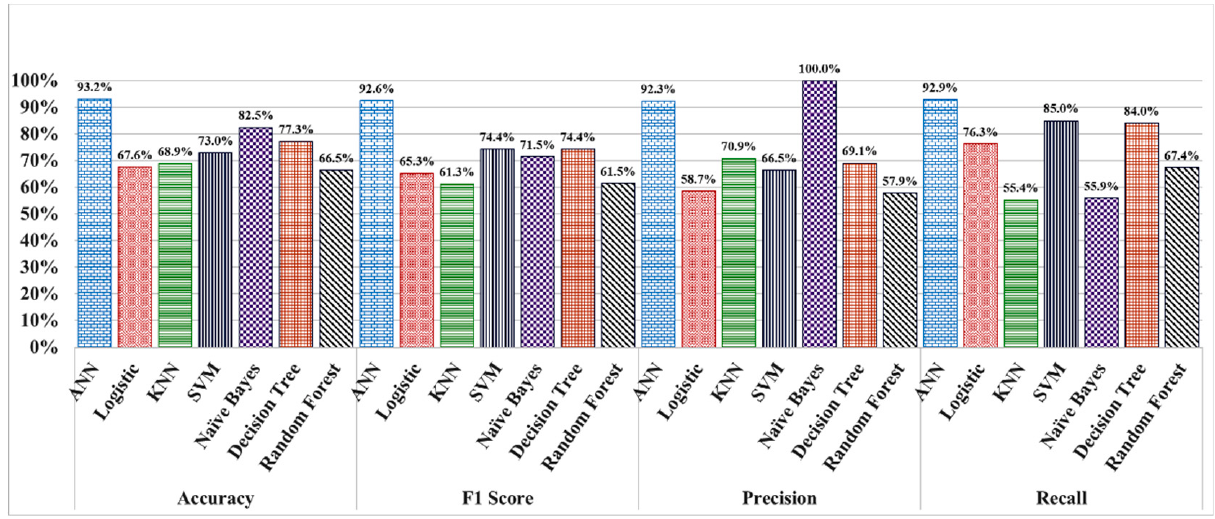
Figure 4. Performance comparison between the statistical methods and the artificial neural network (ANN).